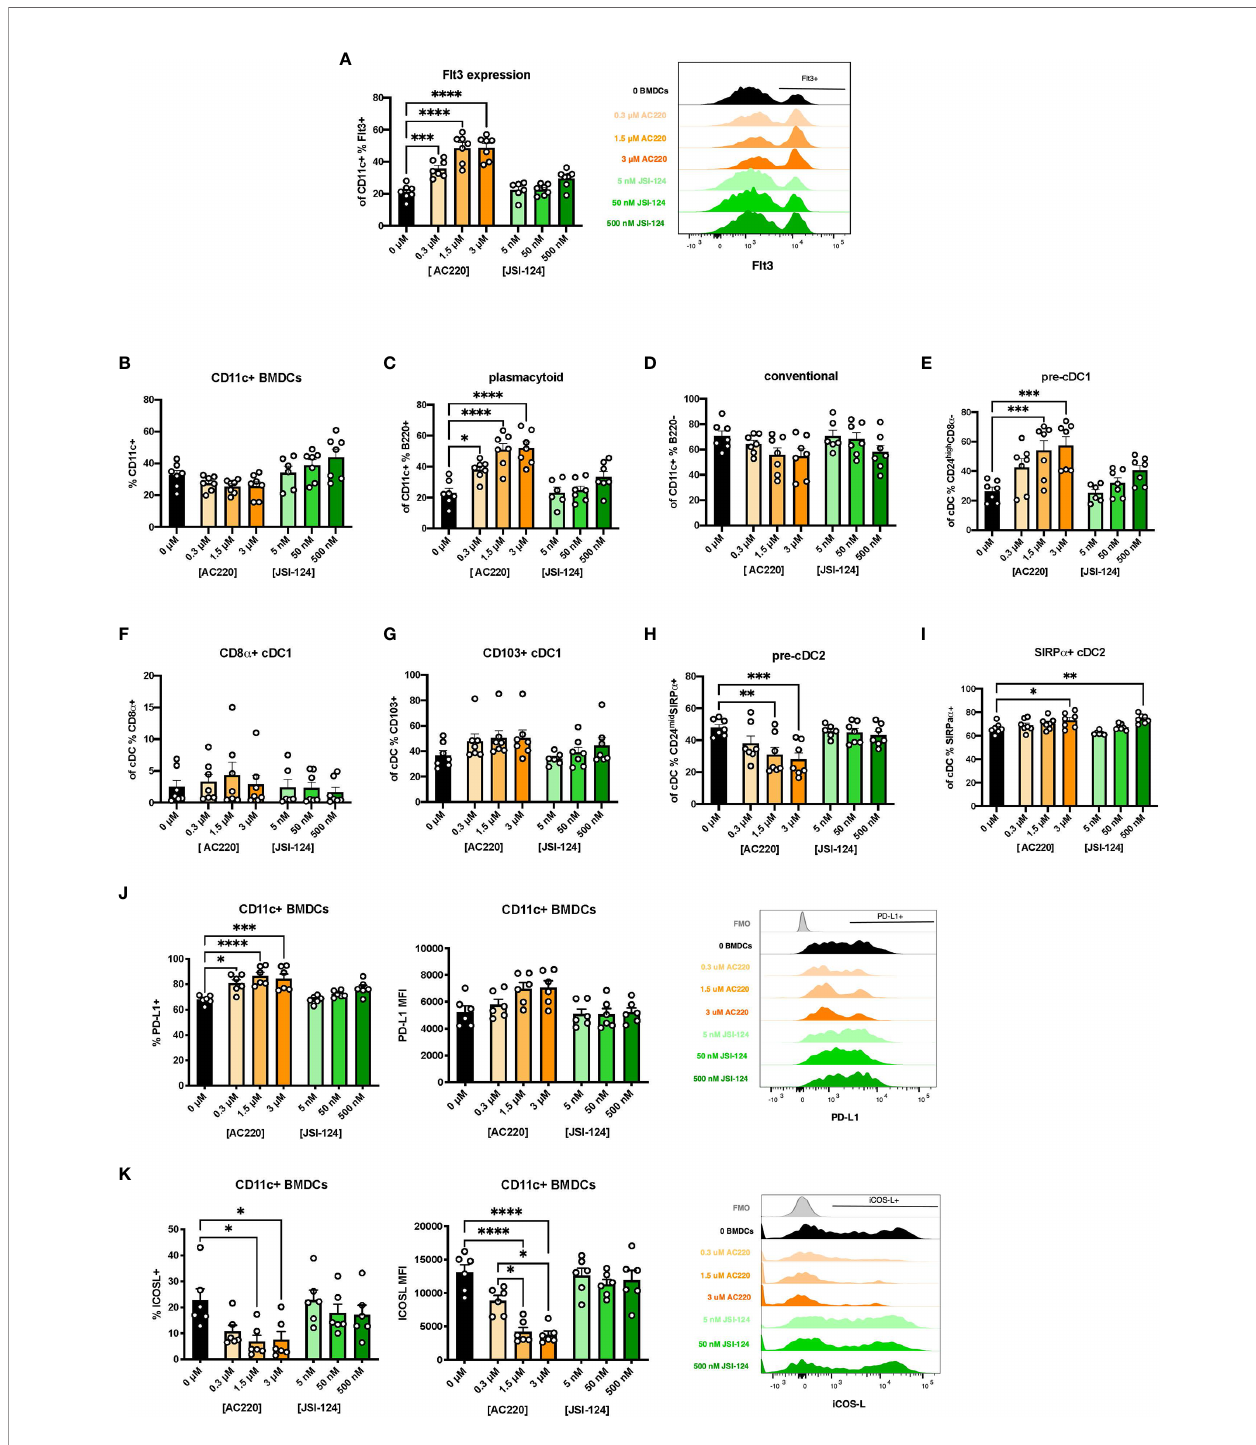
FIGURE 5 | Exposing murine DCs to pharmacological inhibitors of Flt3 and STAT3 phenocopies the effect of BEN exposure. (A-K) BALB/c BMDCs were generated following brief exposure to Flt3 inhibitor (ACC20) or STAT3 inhibitor (JSI-124) and characterized by fl ow cytometry. Data is pooled from 3 independent experiments (n=6-7). (A) Mean percent Flt3 expression among CD11c + BMDCs is shown with SEM, and representative histogram (right). (B-I) Mean percent with SEM of murine DC lineages including (B) total CD11c + , (C) plasmacytoid DCs, (D) conventional DCs, (E) pre-cDC1s, (F) CD8 a + cDC1s, (G) CD103 + cDC1s, (H) pre-cDC2s, and (I) SIRP a + cDC2s. (J) Mean percent PD-L1 expression (left) and MFI (middle) among CD11c + FL-BMDCs shown with SEM, and representative histograms (right). (K) Mean percent ICOS-L expression (left) and MFI (middle) among CD11c + FL-BMDCs shown with SEM, and representative histograms (right). One-way ANOVA and Dunnett ’ s multiple comparisons test were used to determine signi fi cance among groups. *P < 0.05, **P < 0.01, ***P < 0.001, ****P <